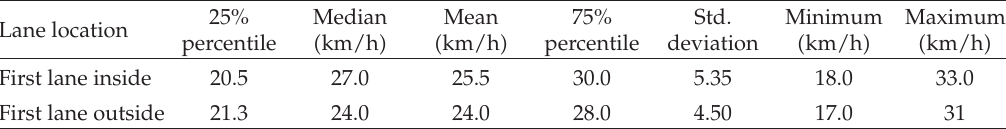
Table 3: The statistical result of speed after breakdown.